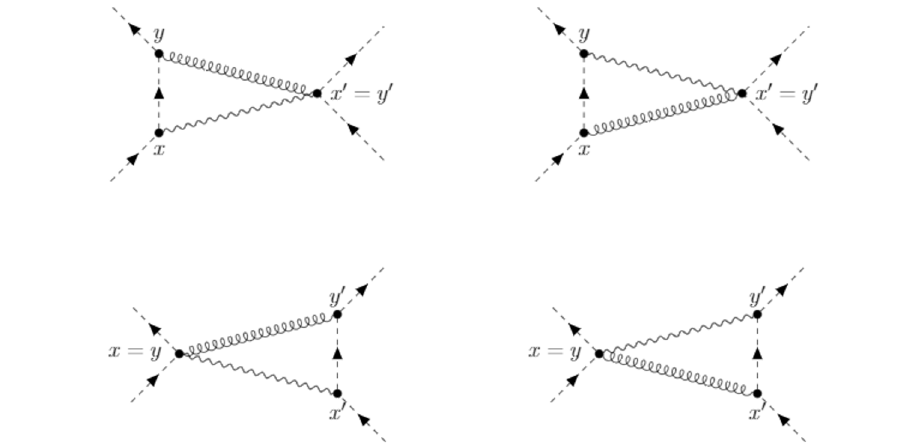
Figure 4 . These diagrams show the contributions from correlations between the source (primed) or observer (unprimed) and the opposite vertex. Dashed lines represent massive scalars, wavy lines represent photons and curly lines represent gravitons. These graphs have the same topology as Bjerrum-Bohr’s Diagram 3